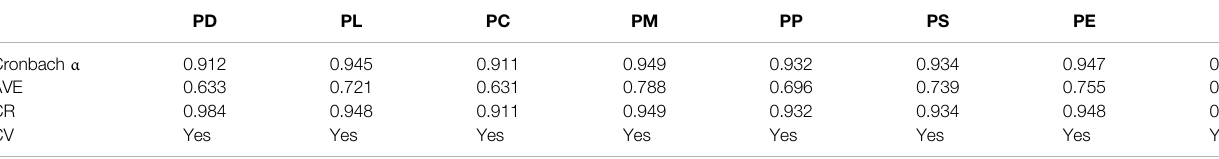
TABLE 5 | AVE and CR for constructs in the supplier survey.